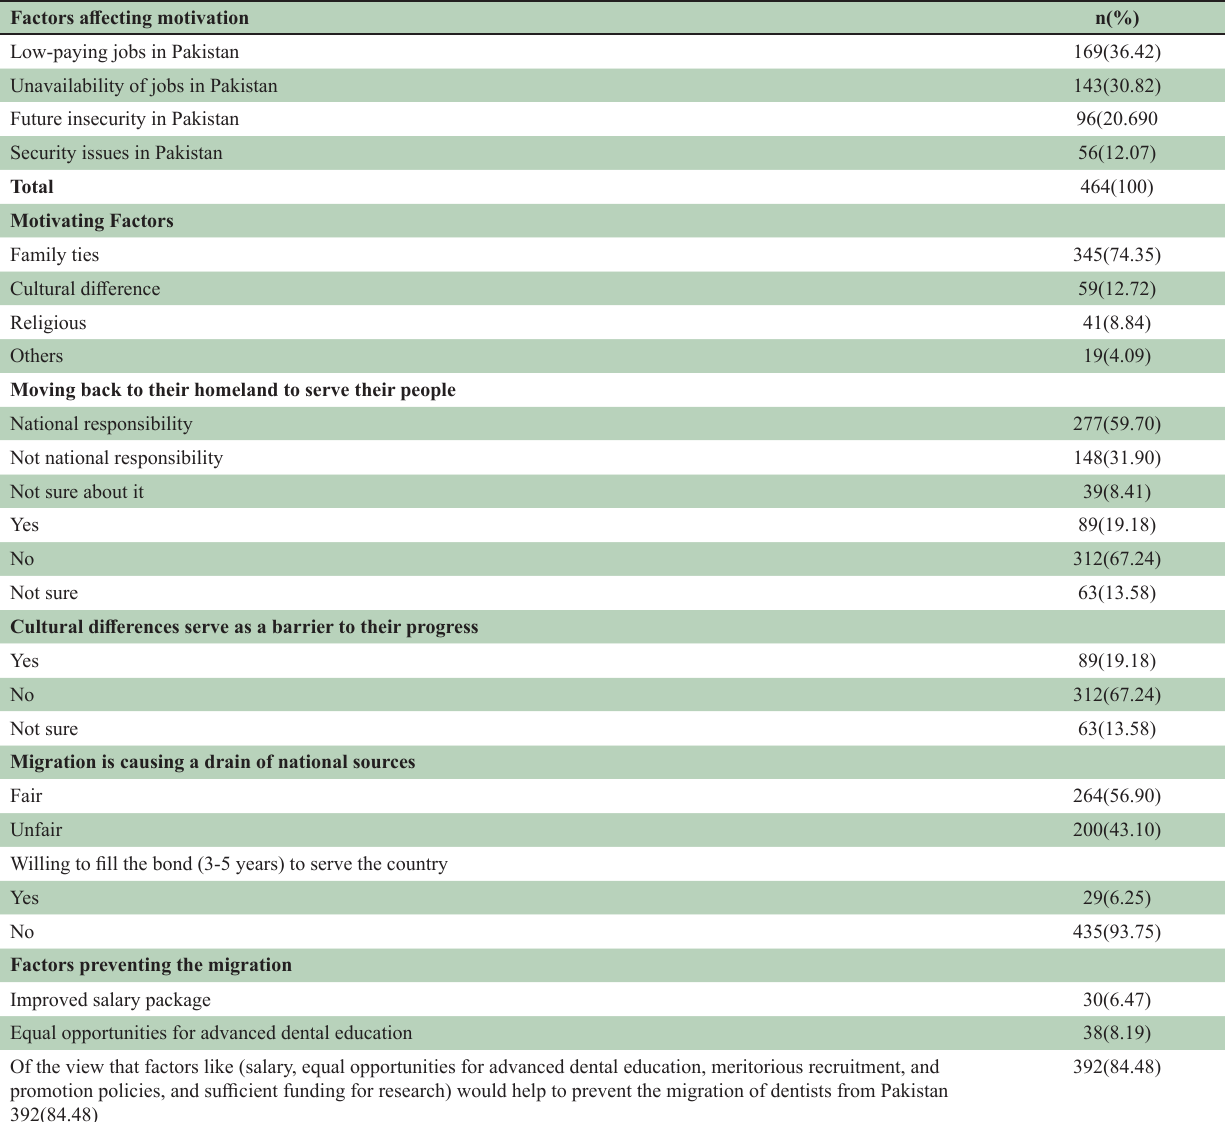
Table-II: Factors affecting motivation to move back to Pakistan.